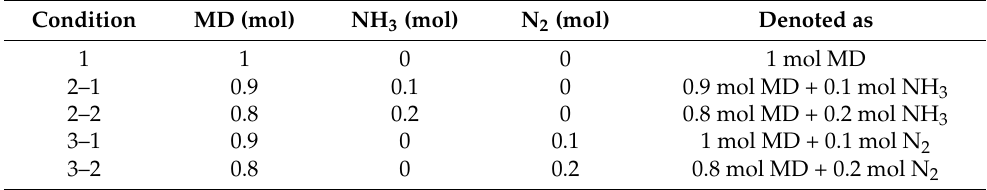
Table 1. Conditions, mixture compositions, and parameters: T = 700–1100 K, p = 6–9 MPa.